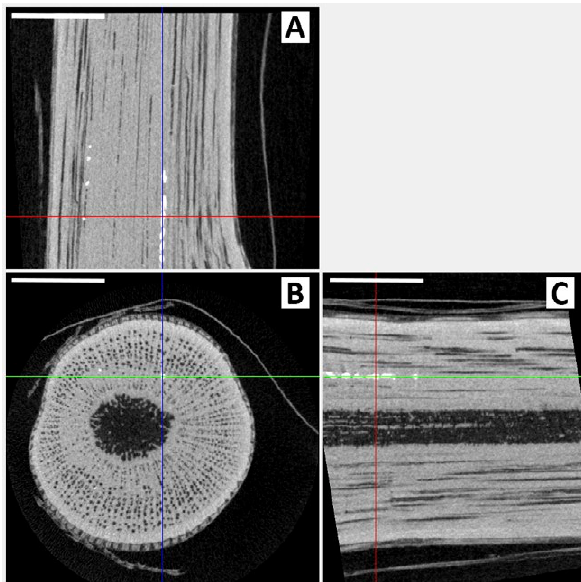
Figure 6. X-Ray microtomography (micro-CT) of a 1-year-old cane of cv. Cabernet Sauvignon. (A and C) Longitudinal sections, and (B) cross-section, with horizontal and vertical lines pinpoint- ing individual xylem vessel(s) filled with gums. Scale bars = 5 mm, resolution 25